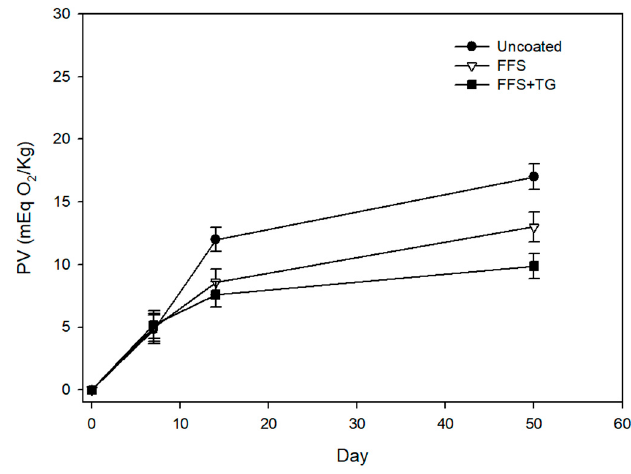
Figure 5. Peroxide value (PV) of uncoated and coated peanuts with FFS or FFS+TG during 50 days of storage. N = 6, values shown are mean ± standard deviation.